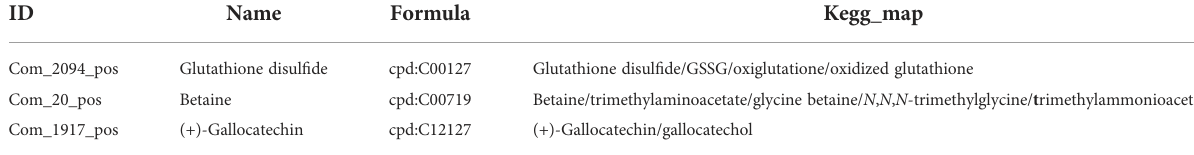
TABLE 3 Three candidate metabolites in positive ion mode for salt-tolerant (ST) sorghum genotypes under salt treatments (T).